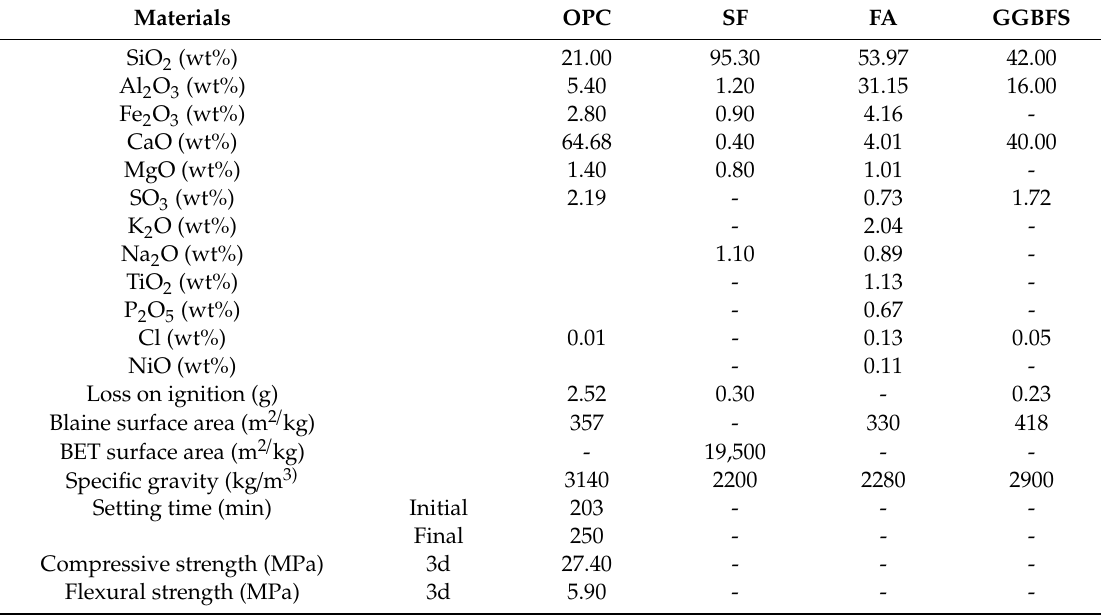
Table 1. Chemical composition and physical properties of cementitious materials *.